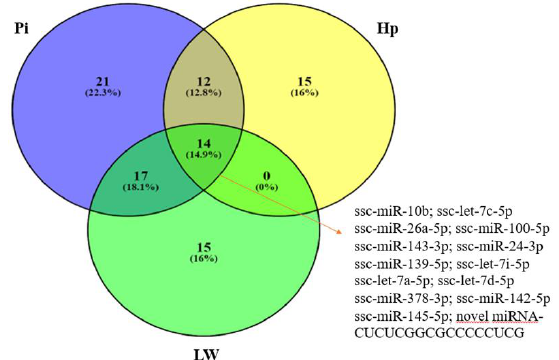
Figure 4. Venn diagram of differentially-expressed miRNAs in subcutaneous fat tissue dependent on fat content in three analyzed breeds (LW, Large White; Pi, Pietrain; and Hp, Hampshire).